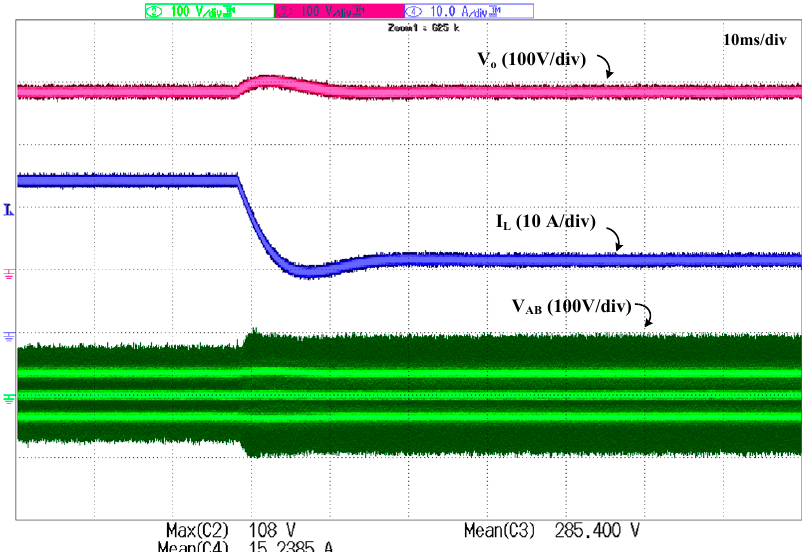
Figure 17. Hardware result for step change in load from full load to 50% load: (1) voltage V AB (100 V/div), (2) inductor current i L (10 A/div), and (3) output voltage V o (100 V/div).